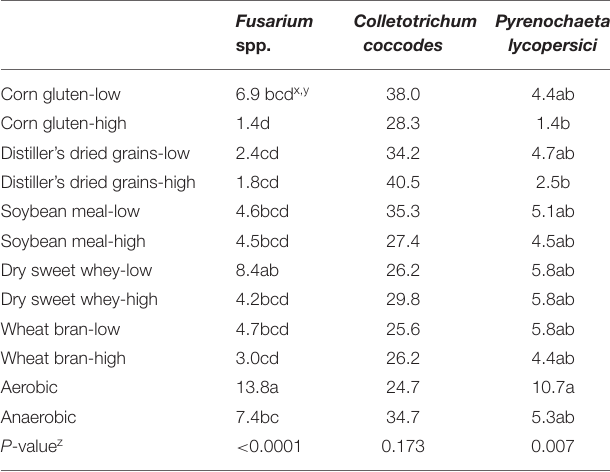
TABLE 1 | Average incidence of root piece infection by various fungi for plants grown in soils treated with anaerobic soil disinfestation with various